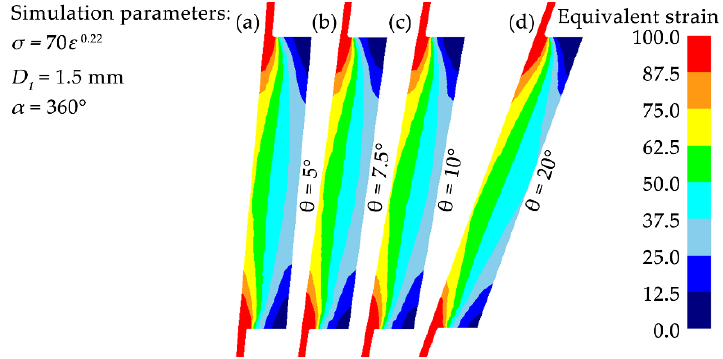
Figure 5. Distribution of equivalent strain across the vertical section of samples with various half cone angles during t -HPS: ( a ) θ = 5°, ( b ) θ = 7.5°, ( c ) θ = 10°, ( d ) θ = 20°.